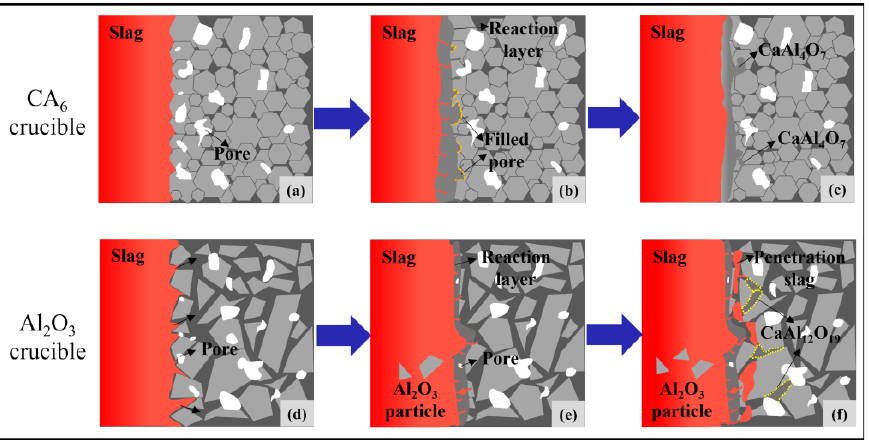
Figure 9. Reaction mechanism of the slag corrosion on the CA 6 and Al 2 O 3 crucible. ( a – e ): The cor-